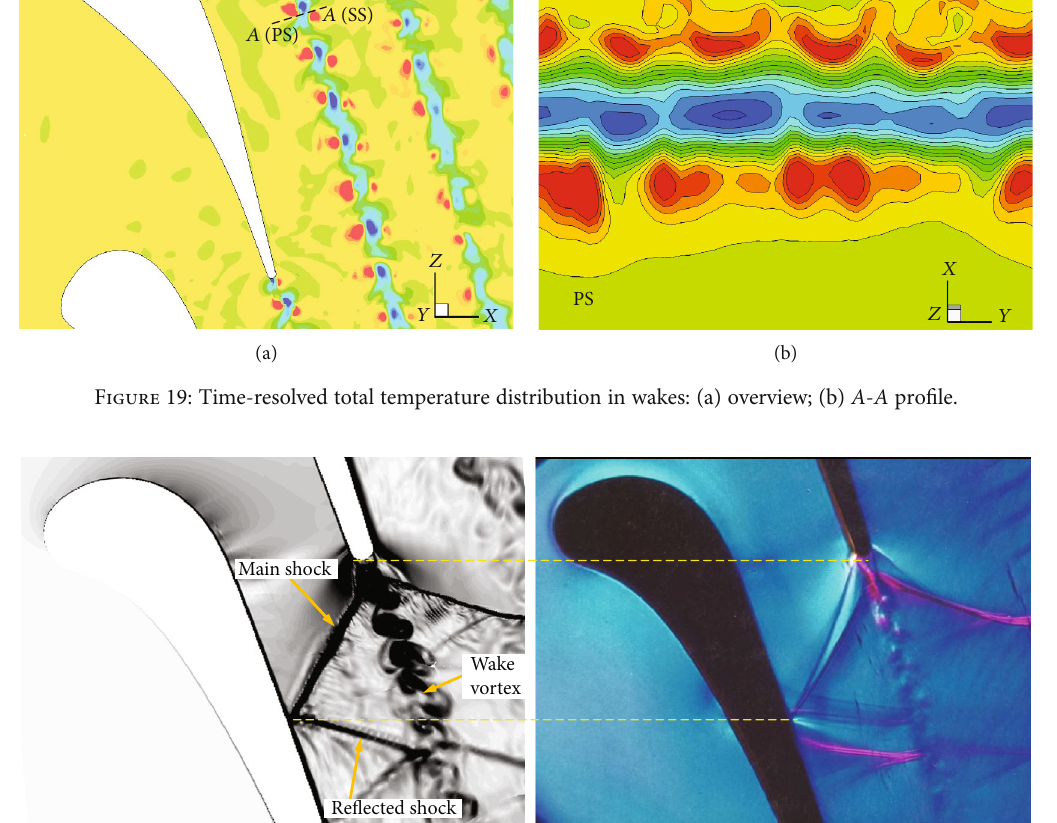
Figure 20: Density gradient contours of Ma